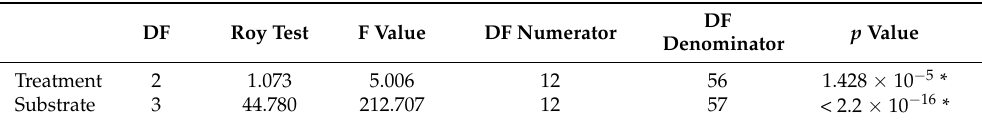
DF = degrees of freedom. * < 0.05 indicates significance